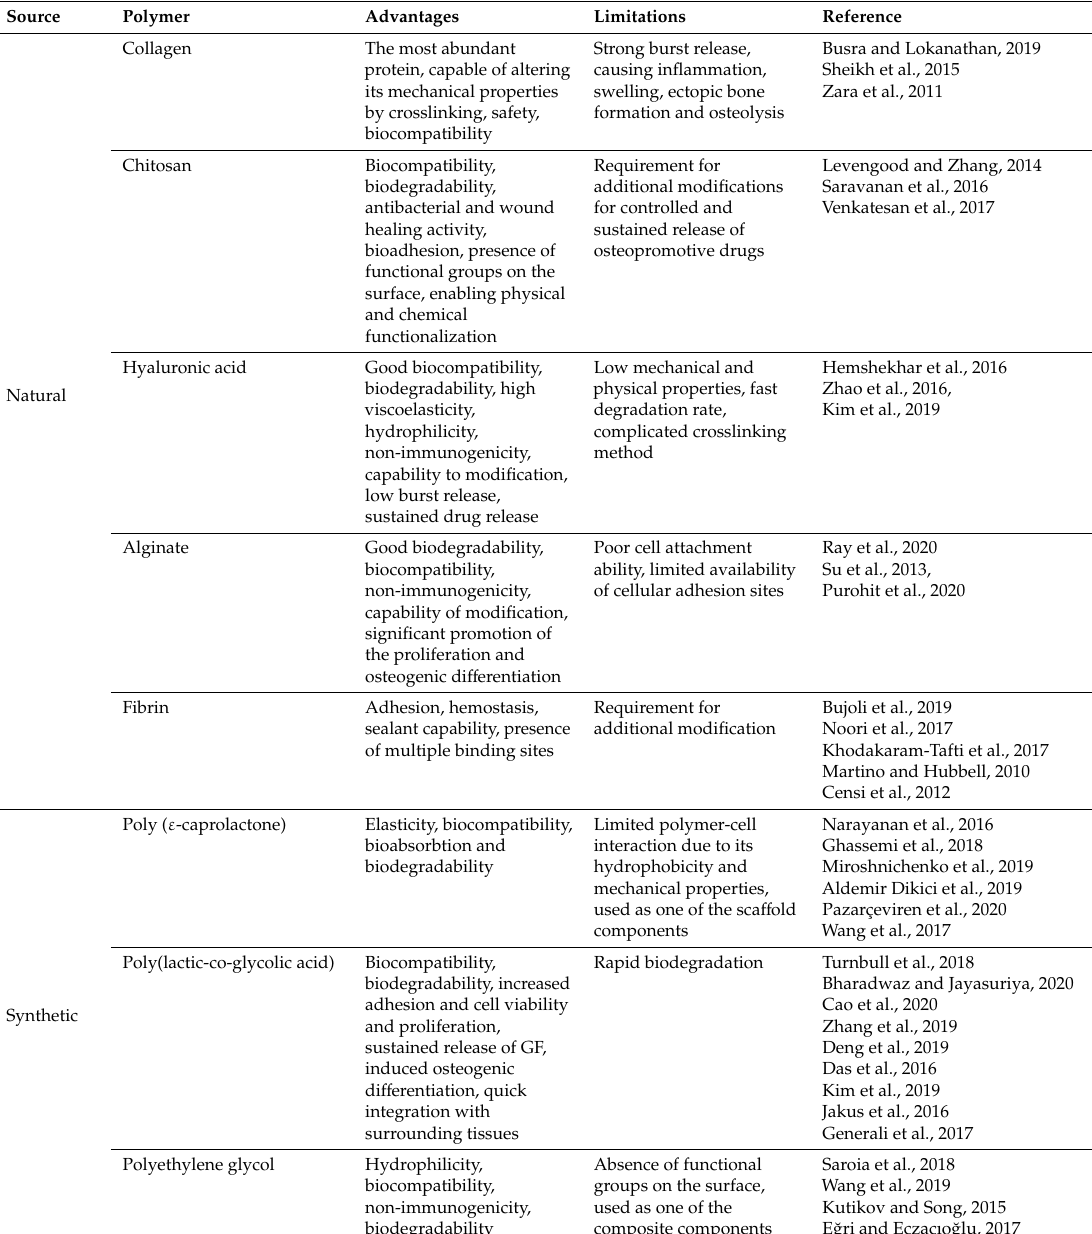
Table 1. Advantages and limitations of polymer-based drug delivery systems for bone tissue regeneration based on a polymer